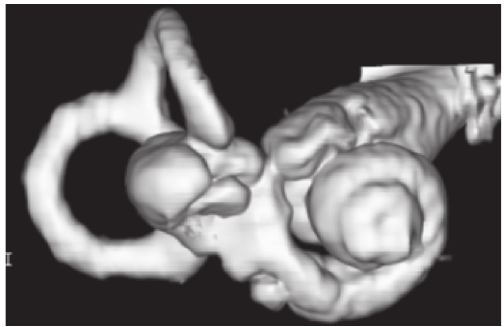
Figure 3: 3D fast imaging employing steady-state acquisition- cycled phases (FIESTA-C) magnetic resonance imaging (MRI). The fusion of the vestibules and the lateral semicircular